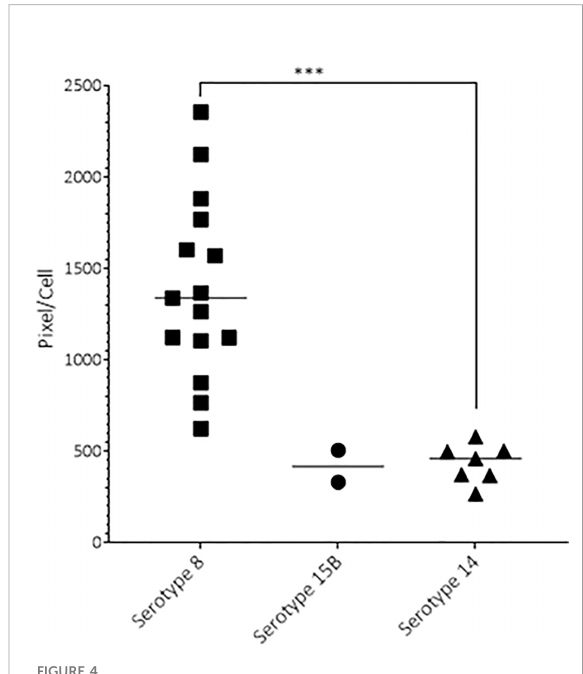
FIGURE 4 Capsule size of pneumococcal serotypes 8, 15B and 14 recovered 19 hours post infection. At 19 hpi, the serotype 8 strain had a signi fi cantly thicker capsule than the serotype 14 strain (p-value < 0.001). One point represents the average pixel/ cell of one image with at least 1 bacterium. Animals infected with serotype 8 had more bacteria, thus more data points. ***p <